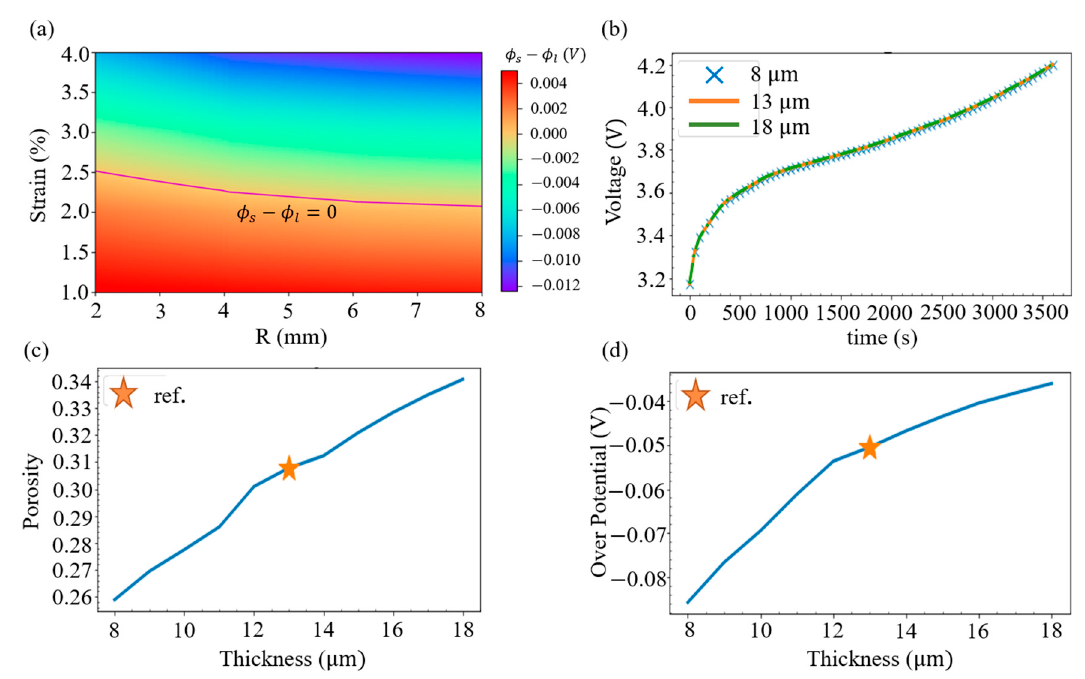
Figure 8. ( a ) Map of the SR overpotential at the intersection of r = 0 and the junction of the anode and the separator. ( b ) History of the voltage with three separator thicknesses. ( c ) Relation between the porosity and the separator thickness; the reference thickness is also indicated. ( d ) Relation between the SR overpotential and the separator thickness.